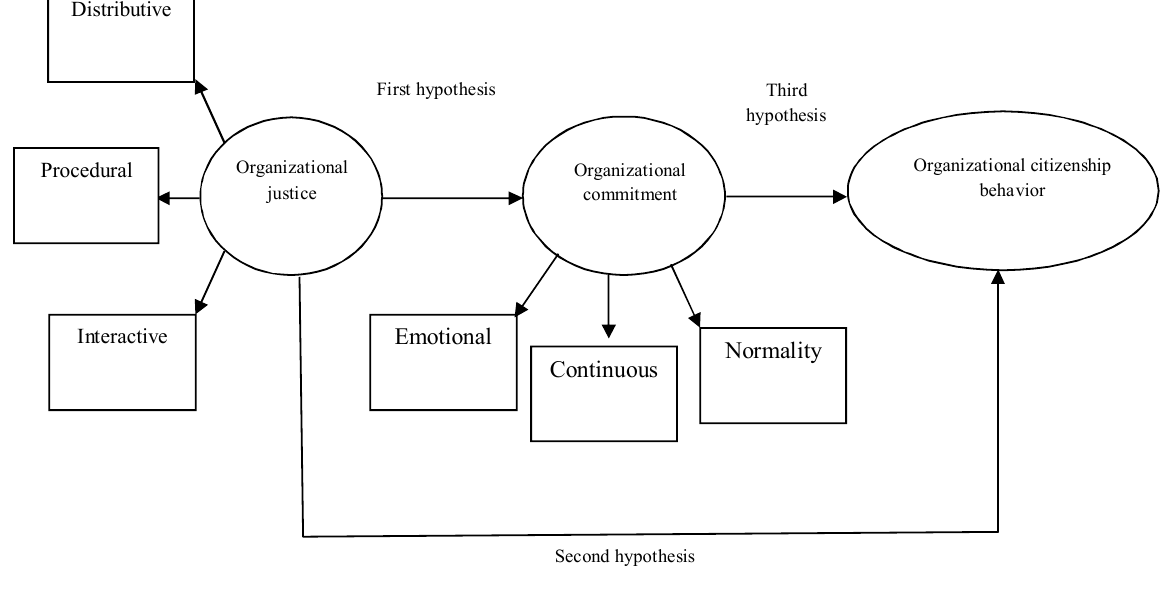
Fig. 1. The proposed study